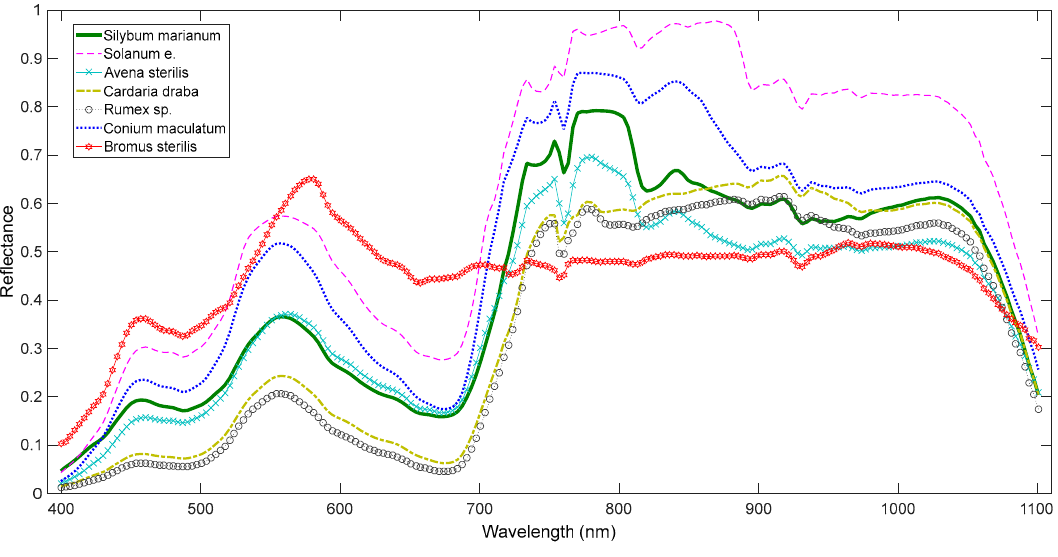
Figure 2. Spectra corresponding to each vegetation type.